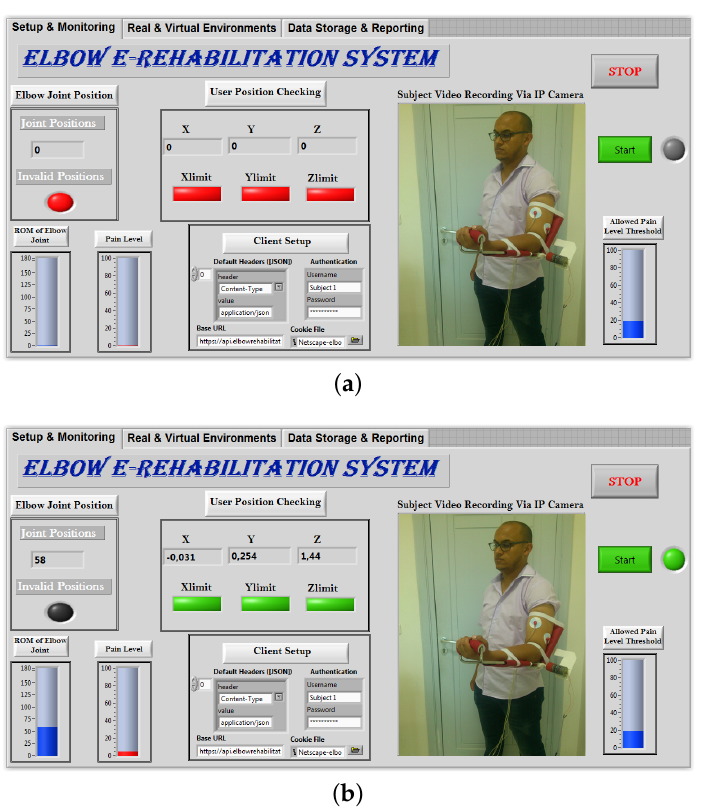
Figure 5. Setup sequences: ( a ) invalid position for control; ( b ) suitable position for control.